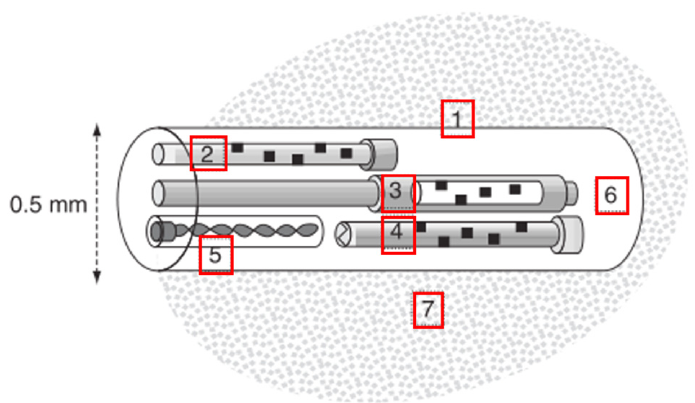
Figure 4. Schematic diagram of the sensor in the NeuroTrend system 1. Microporous polyethylene tube; 2. PbtO 2 sensor (ruthenium dye in an organosilicon matrix); 3. PbCO 2 sensor (phenol red in a supercarbonate solution); 4. pH sensor (phenol red in a polyacrylamide gel); 5. Thermocouple (cop- per wire and constantan wire); 6. Phenol red and polyacrylamide gel; and 7. Target monitoring area of the brain [31].